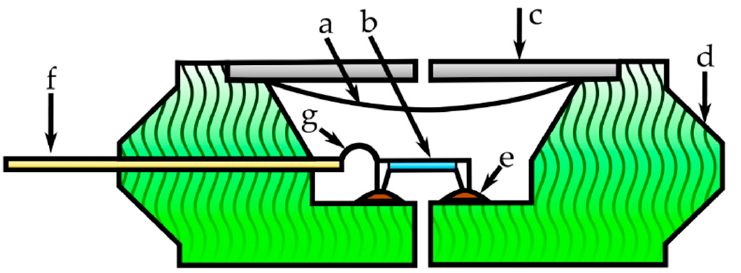
Figure 1. MEMS technology pressure transducer cross-section, a—protective gel cover, b—measuring structure (silicon membrane), c—metal part of the cover, d—main cover, e—measuring structure place of attachment, f—signal output, and g—pins (Image drawn based on the literature informations [18– 23]).